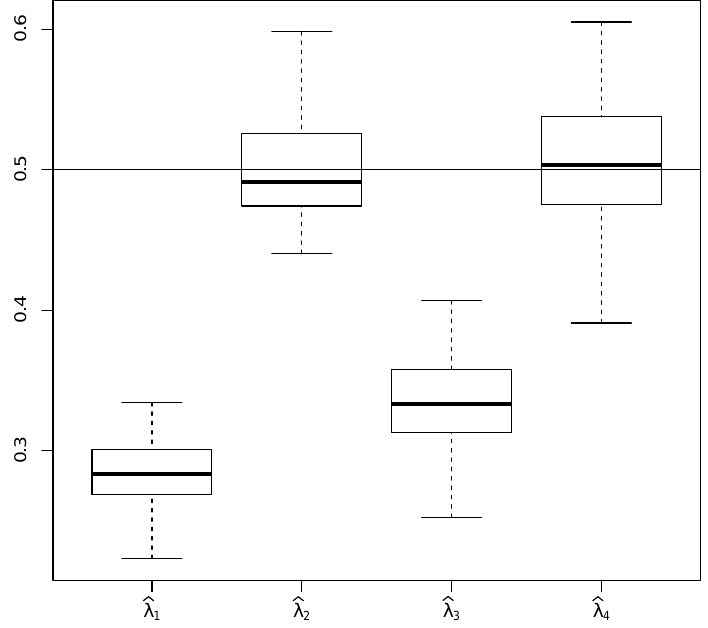
Figure 3. Comparison of (cid:98) λ 1 , (cid:98) λ 2 , (cid:98) λ 3 and (cid:98) λ 4 for 100 trajectories, where H = 0.6, x 0 = 0, T = 1000, h = 1, σ = 2; the horizontal line shows the true value of the estimated parameter λ =